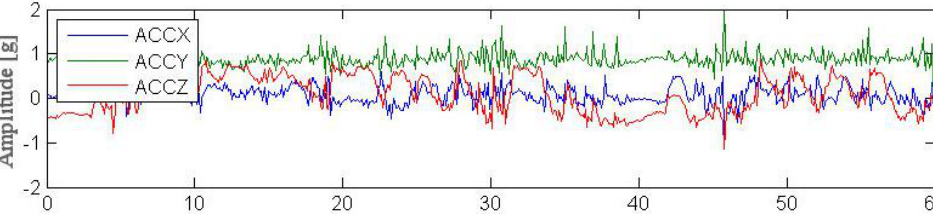
Figure 10. Data acquired from wearable accelerometer 60 s trees